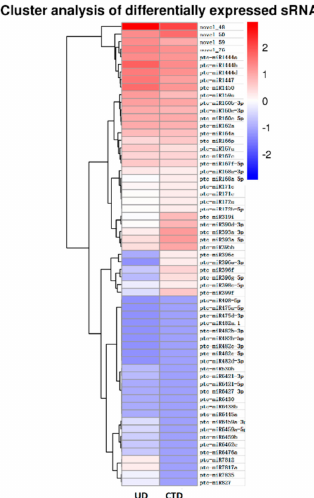
Figure 3. Hierarchical clustering of di ff erentially expressed sRNAs in Populus simonii × P. nigra under cold-treated and untreated